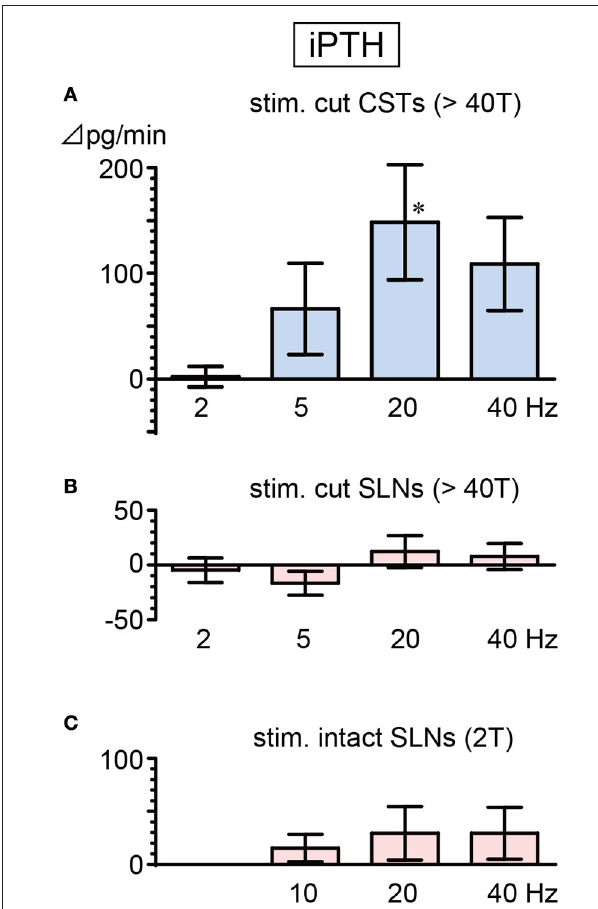
FIGURE 4 | Changes in iPTH secretion rate during electrical stimulation of cut CST (A) , cut SLN (B) , and intact SLN (C) at various stimulus frequencies. X-axis: frequency of stimulation. Y-axis: changes in iPTH secretion rate from prestimulus values. Columns and vertical bars show the mean ± standard error. Significant differences were determined by comparison with the prestimulus control values (* p < 0.05). ± 2 µ l/min during stimulation of intact SLNs at 10, 20, and 40 Hz, respectively ( p < 0.012).